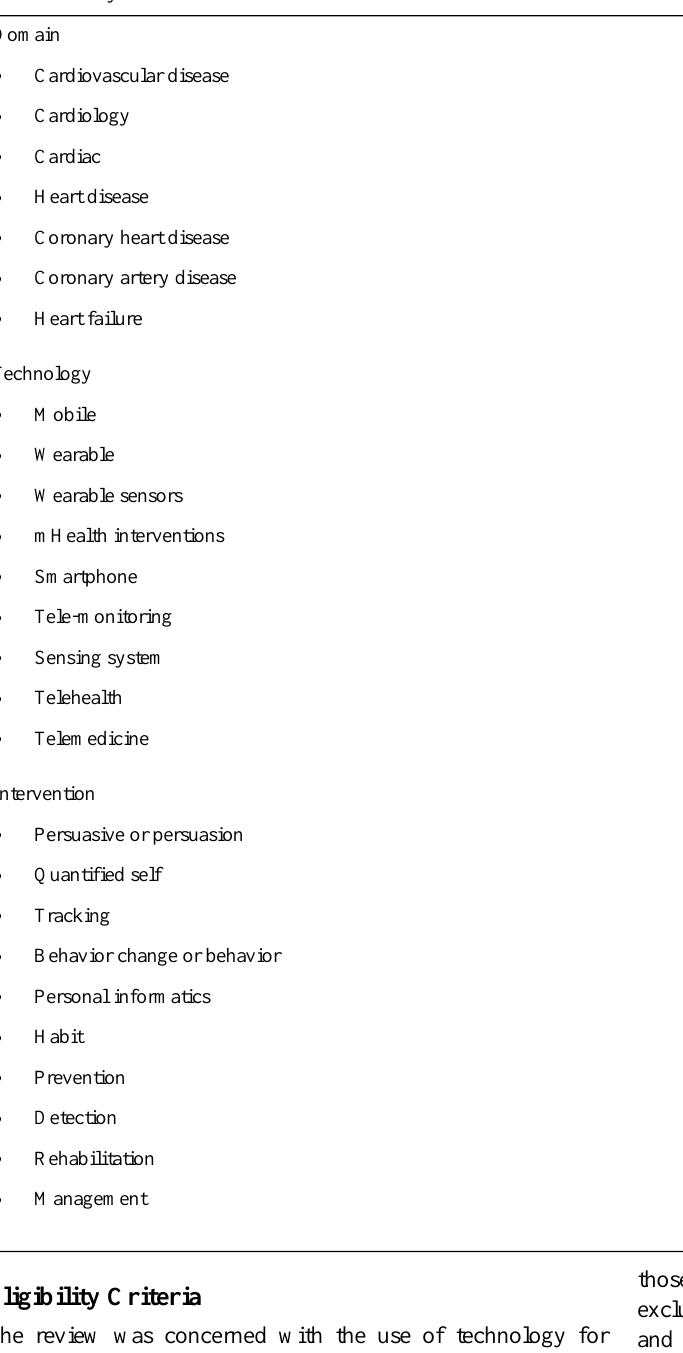
Textbox 1. Keywords used in the search